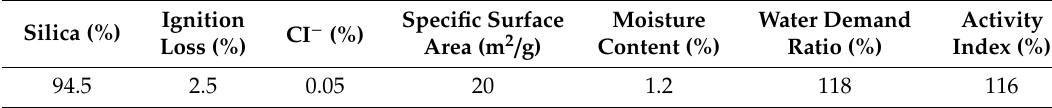
Table 2. Silica-fume index parameters.